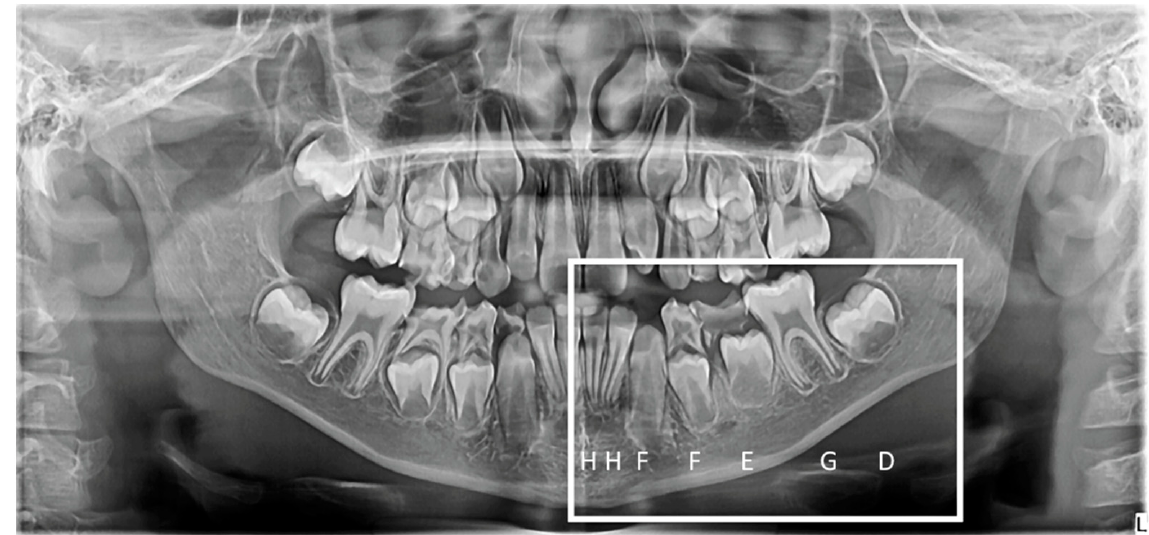
Figure 3. Exemplification of Demirjian’s method for dental age assessment.